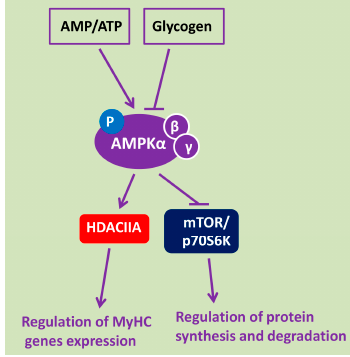
Figure 1. Key physiological regulators of 5 ′ adenosine monophosphate -activated protein kinase (AMPK) activity in skeletal muscle and physiologically-relevant AMPK targets. (original scheme)